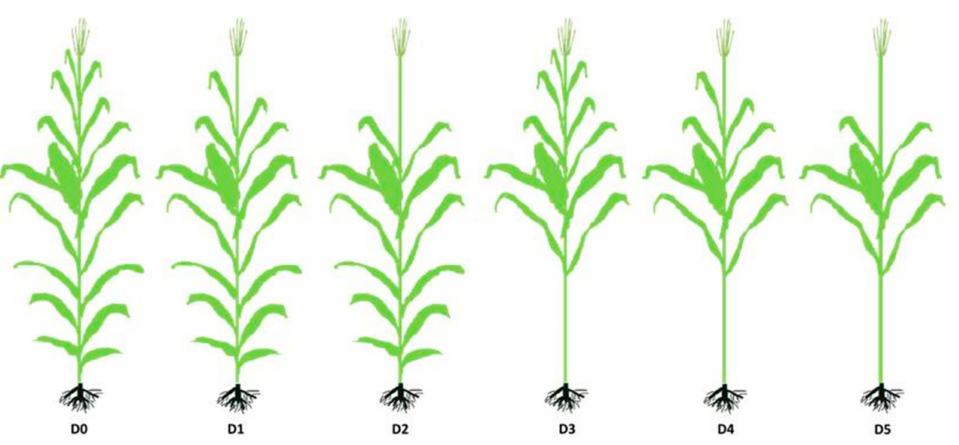
Figure 1. Schematic diagram of di ff erent leaf removal treatments. D0 was the control with no leaves removed, D1 with the two uppermost leaves removed, D2 with the four uppermost leaves removed, D3 with the leaves below the third leaf below the ear removed, D4 with the two uppermost leaves and the leaves below the third leaf below the ear removed, D5 with the four uppermost leaves and the leaves below the third leaf below the ear